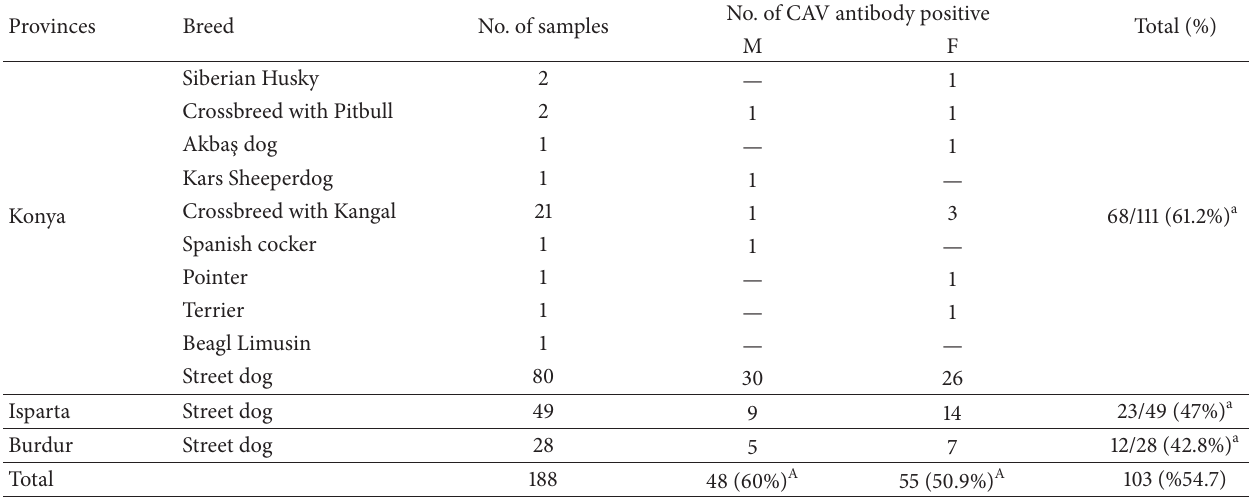
Table 3: Results of CAV antibody status according to province, breed, and sex.